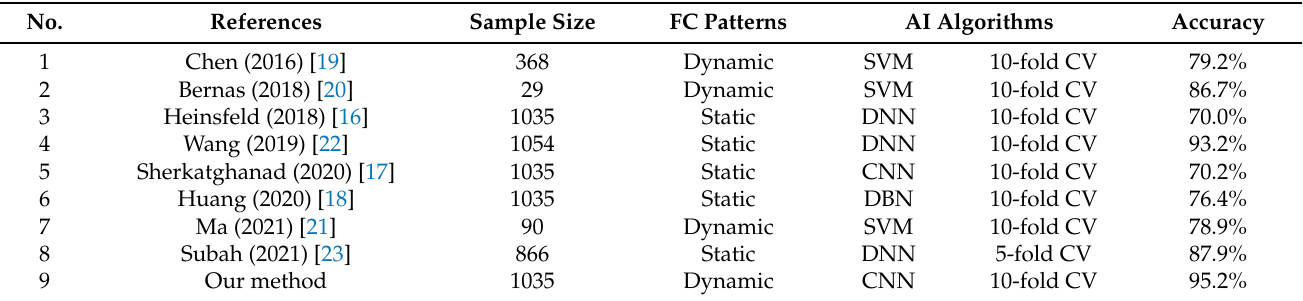
Table 5. Benchmarking with existing ASD classification methods using ABIDE